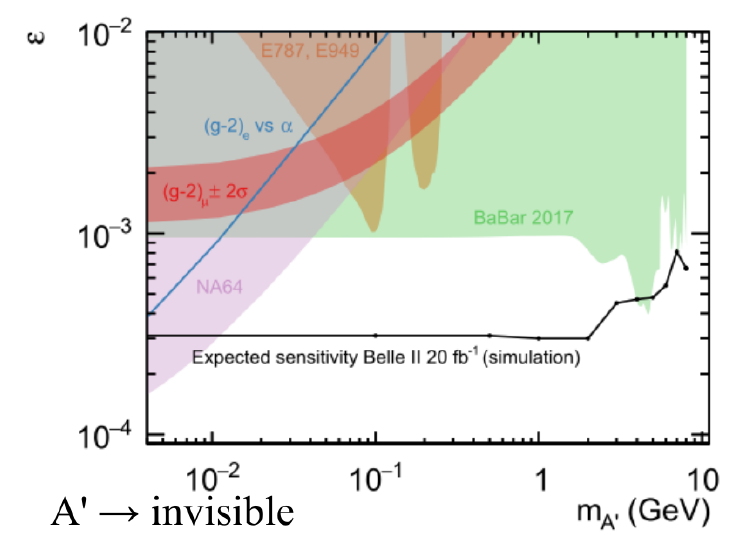
Figure 4. Expected Belle II sensitivity to the dark photon searches from monophoton events. Sensitivity to (cid:31) coupling vs. dark photon mass m A